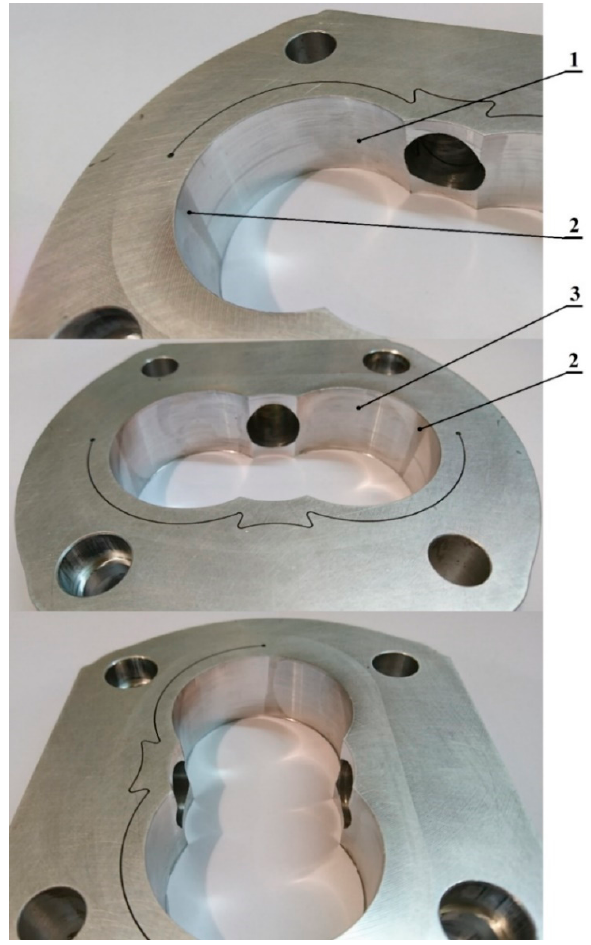
Figure 16. Traces of interaction between gears and casing in integrated lips acc. to patent PL223649 (patent application P.404801 [22]), and with displacement limiter acc. to patent PL234070